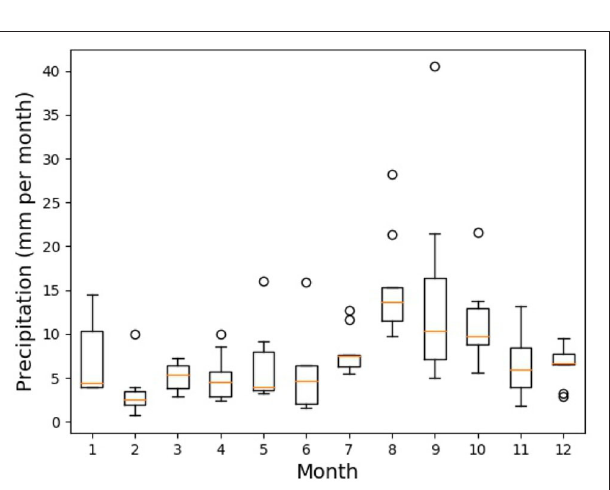
FIGURE 9 | Precipitation at EastGRIP obtained from model MAR re-analyses. Statistics over the period